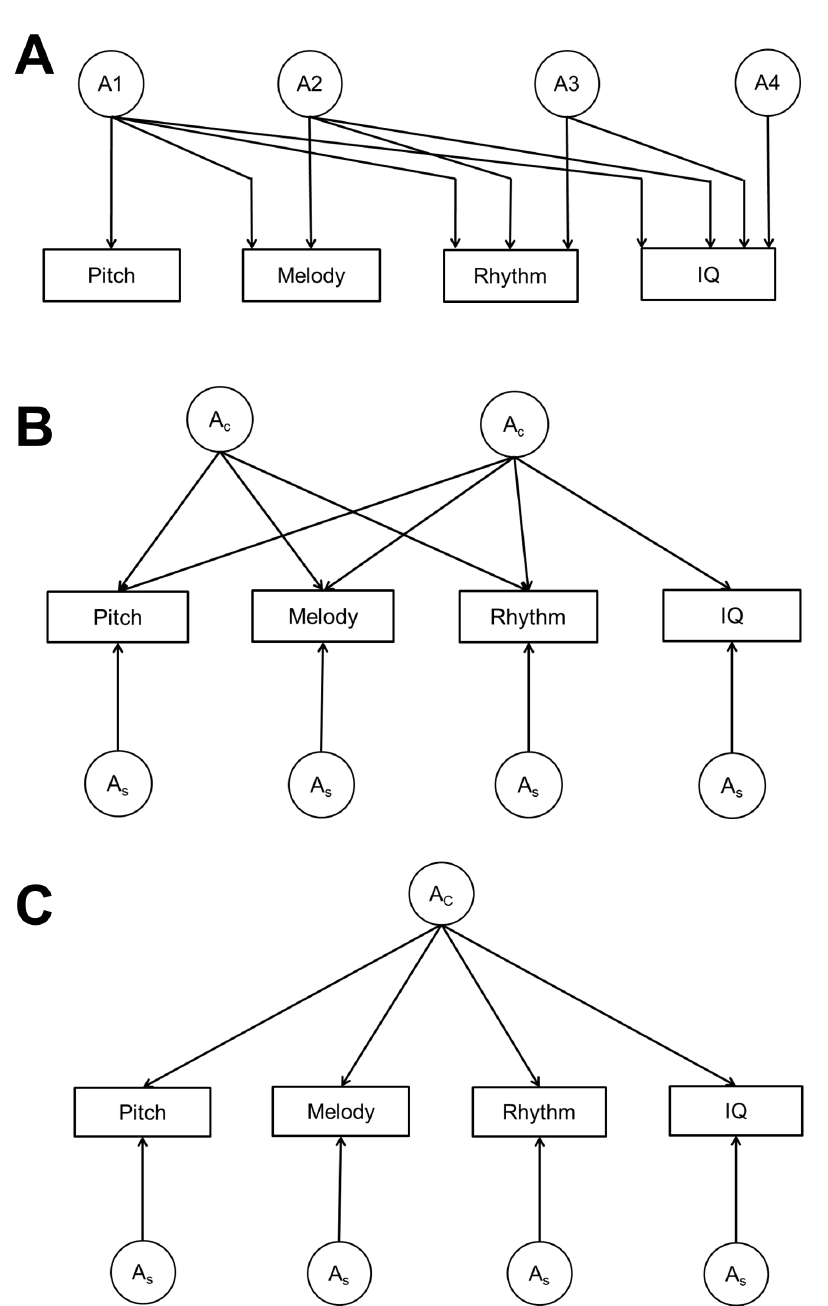
Figure 1. Different models applied to the data. (A) Cholesky decomposition. (B) Independent pathway model with two common genetic factors. (C) Independent pathway model with one common genetic factor. A 5 additive genetic influences. Subscripts c and s denote common and specific influences, respectively. Genetic factors of the Cholesky decomposition are labelled A1, A2, A3, and A4.